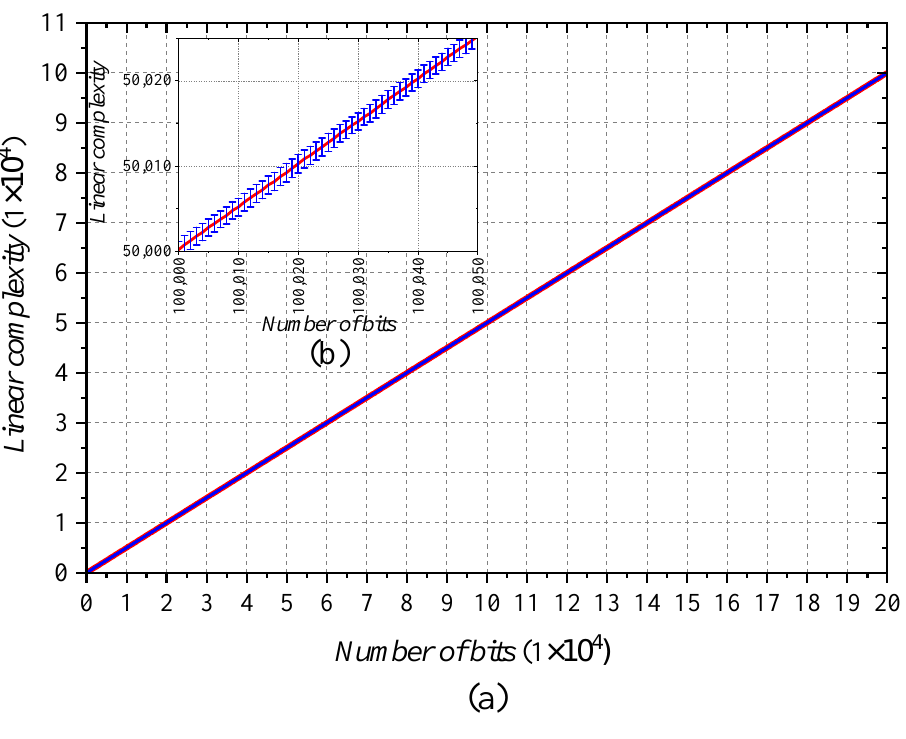
Figure 13. Linear complexity profile for 1000 sequences of pseudorandom numbers for the pro- posed PRNG. ( a ) considering sequences from 1 to 200,000 bits. ( b ) zoom of ( a ) considering sequences from 100,000 to 100,050